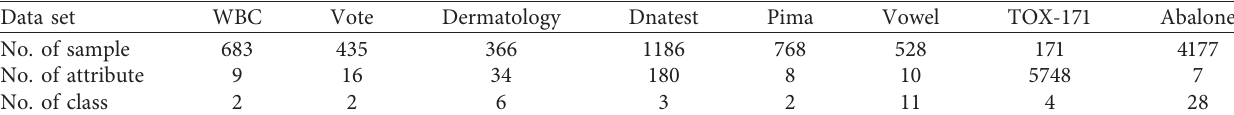
Figure 2: Connection between clustering results and weights. (a), (b) Original graph of artificial data set. (c), (e) Clustering result graph. (d), (f) Weight connection diagram. Table 5: Real data set information.